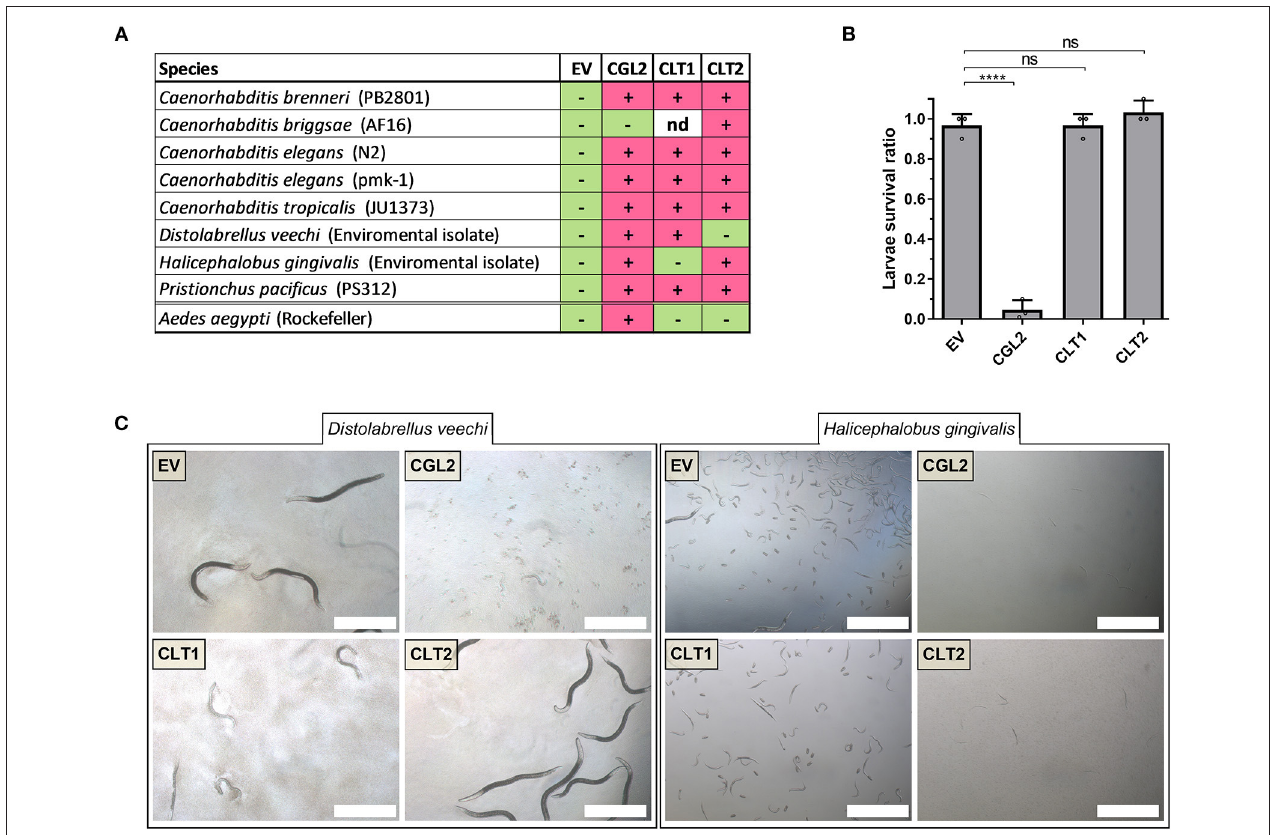
FIGURE 5 | Toxicity of CLT1 and CLT2 against bacterivorous nematodes and an omnivorous insect. (A) Toxicity spectrum of CLT1 and CLT2 proteins was assessed against seven different species of bacterivorous nematodes and larvae of the mosquito Aedes aegypti . Minus (–), lack of toxicity; plus ( + ), presence of toxicity; nd, not determined. (B) Toxicity of CLT1 and CLT2 against A. aegypti larvae was quantified by counting number of survived larvae after 4 days of feeding on IPTG-induced E. coli BL21 bearing CLT1 or CLT2. E. coli BL21 expressing either previously characterized nematotoxic protein CGL2 or carrying an “empty” vector (EV) were used as positive and negative controls, respectively. Dunnett’s multiple comparisons test was used for statistical analysis. Error bars represent standard deviation of three biological replicates. *** p < 0.001, **** p < 0.0001 vs. EV. (C) Differential susceptibility of D. veechi and H. gingivalis against two lipases when they were fed with IPTG-induced E. coli BL21 for 72h containing either an “empty” vector (EV) or expressing CGL2 or CLT1 or CLT2. Scale bar = 500 µ